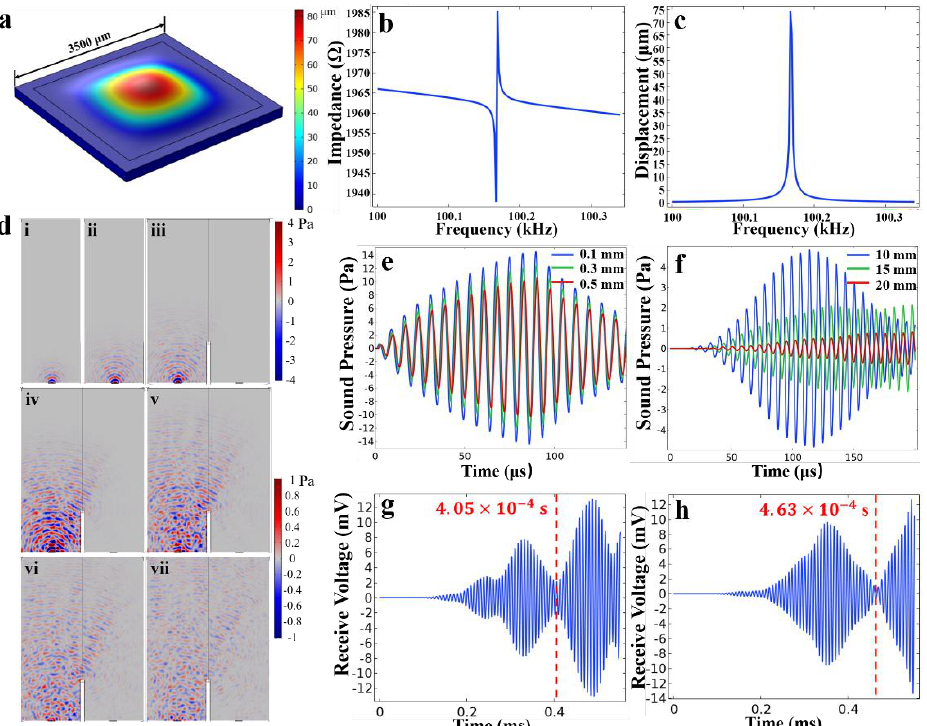
Figure 2. The finite element simulation results of PMUTs. ( a ) The first vibration mode diagram of PMUT. ( b ) Impedance and ( c ) displacement versus the frequency characteristics of the PMUT. ( d ) Propagation state of ultrasound when the time is ( i ) 30 µ s, ( ii ) 60 µ s, ( iii ) 90 µ s, ( iv ) 120 µ s, ( v ) 150 µ s, ( vi ) 180 µ s and ( vii ) 210 µ s. The grayness in the picture is the air domain. The upper part of the air is the reflector. PMUTs are located on both sides of the bottom. The left is the transmitter and the right is the receiver. In the middle of the air is a baffle to prevent interference between the transmitter and receiver. ( e ) Near−field and ( f ) far−field sound pressure versus time, where the points of near−field and far−field sound pressure are 0.1, 0.3, 0.5 mm and 10, 15, 20 mm from the center of the film, respectively. The receiving voltage of the receiver when the sensing distance is ( g ) 7 cm and ( h ) 8 cm. The red dashed line is the arrival time of the reflected wave, and the specific time is marked on the left.